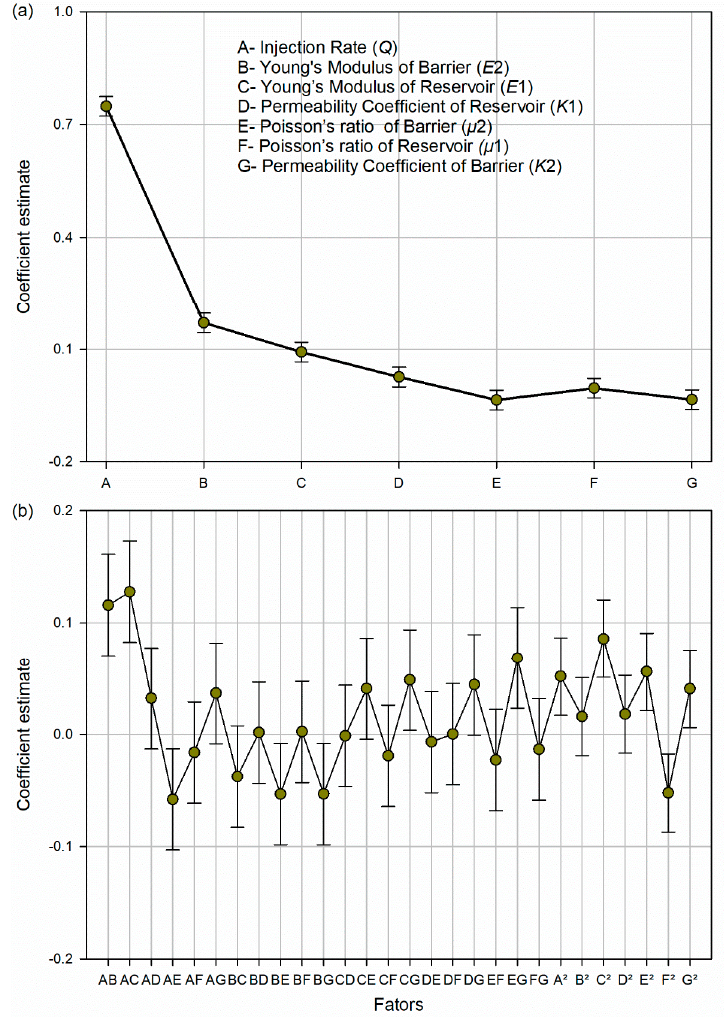
Figure 8. Coe ffi cients referred to coded parameters and their standard errors. ( a ) Coe ffi cient estimates Figure 8. Coefficients referred to coded parameters and their standard errors. ( a ) Coefficient estimates of single factors and ( b ) coefficient estimates of joint action parameters. of single factors and ( b ) coe ffi cient estimates of joint action